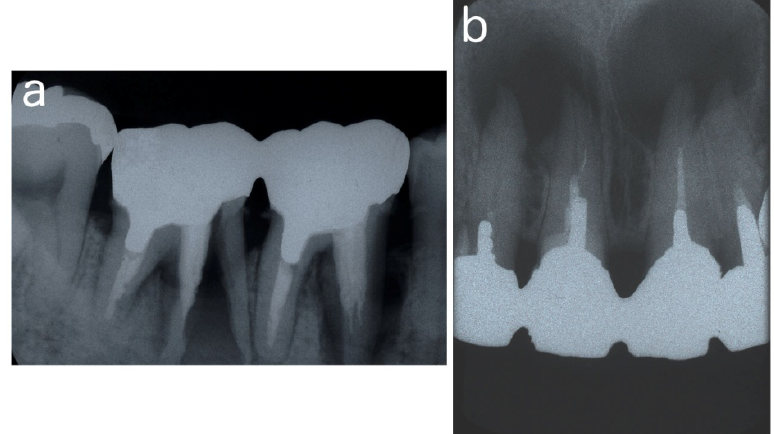
Figure 3. ( a ) Root fracture of right mandibular second molar; ( b ) Critical size of periapical lesion of maxillary